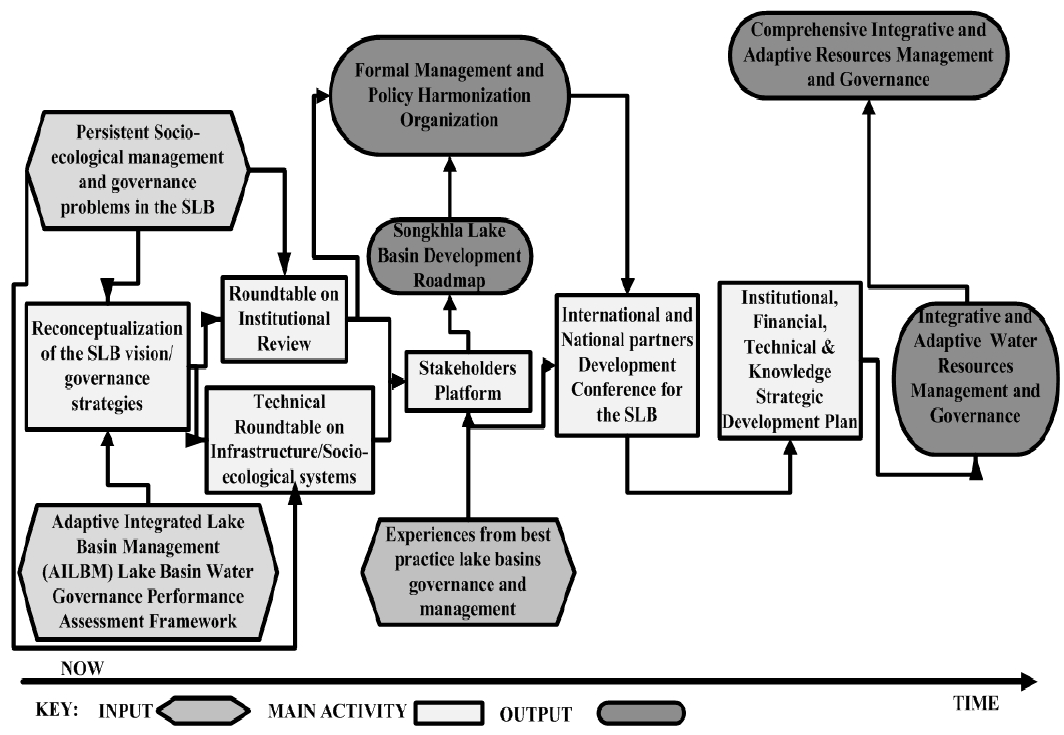
Figure 4. Possible transformation pathway towards adaptive and integrative Songkhla Lake Basin water resources management and governance.